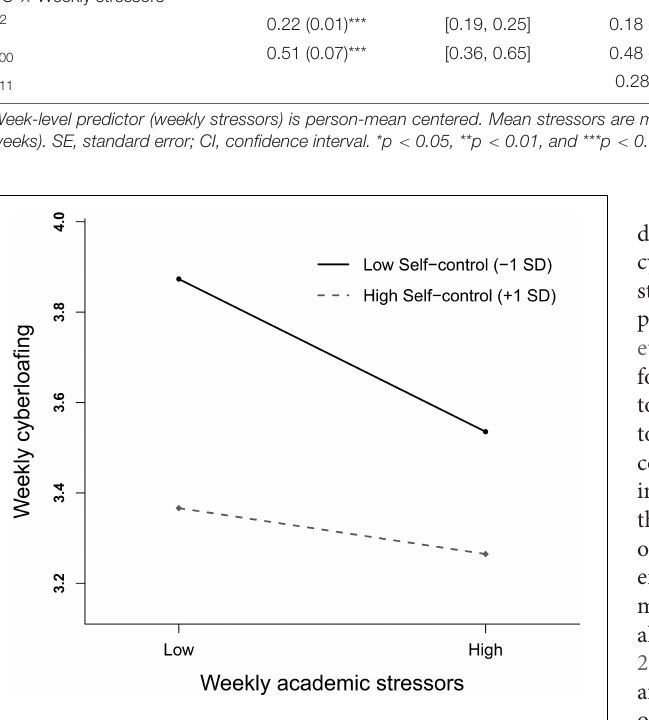
FIGURE 2 | Trait self-control moderating the relationship between academic stressors and cyberloafing